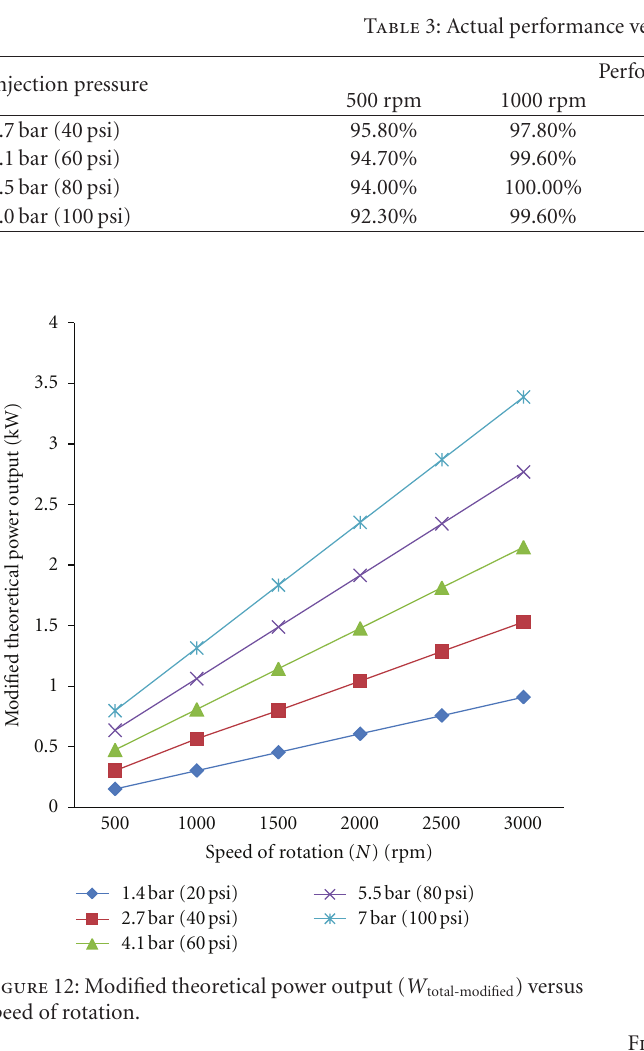
Figure 13: Performance of vane turbine with respect to modified theoretical